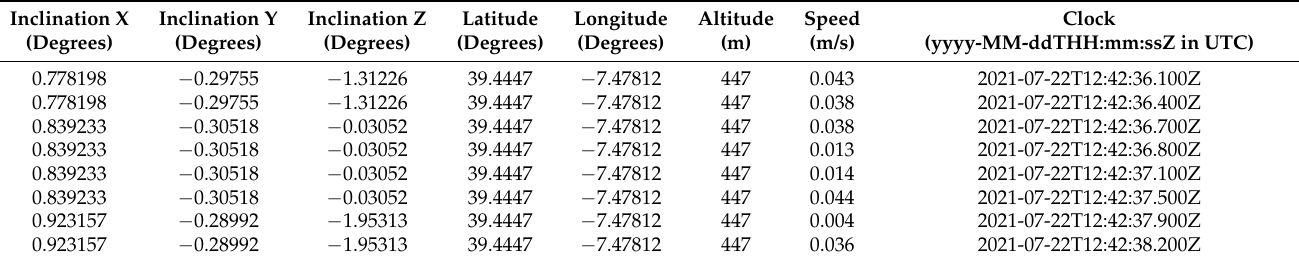
Table 3. Example of values extracted from the raw